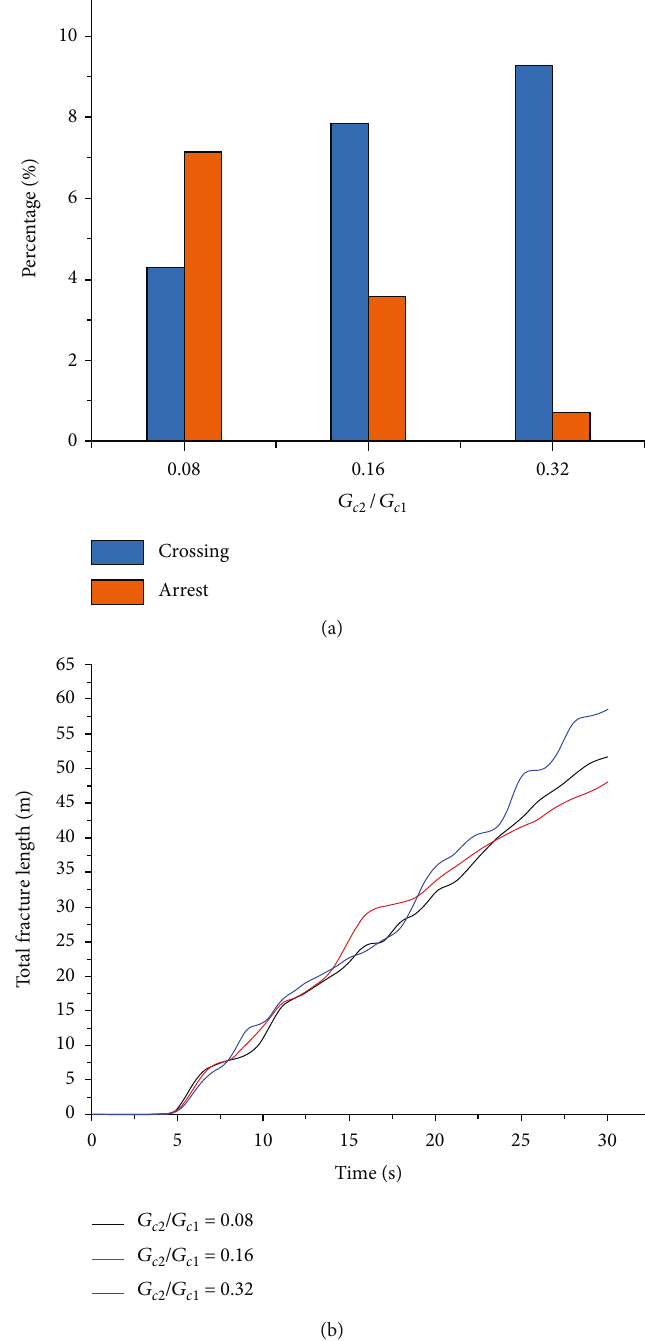
Figure 14: (a) Numbers of events that hydraulic fractures are crossing and arrested by natural fractures with di ff erent fracture energy ratios. (b) Fracture propagation length for varying fracture energy